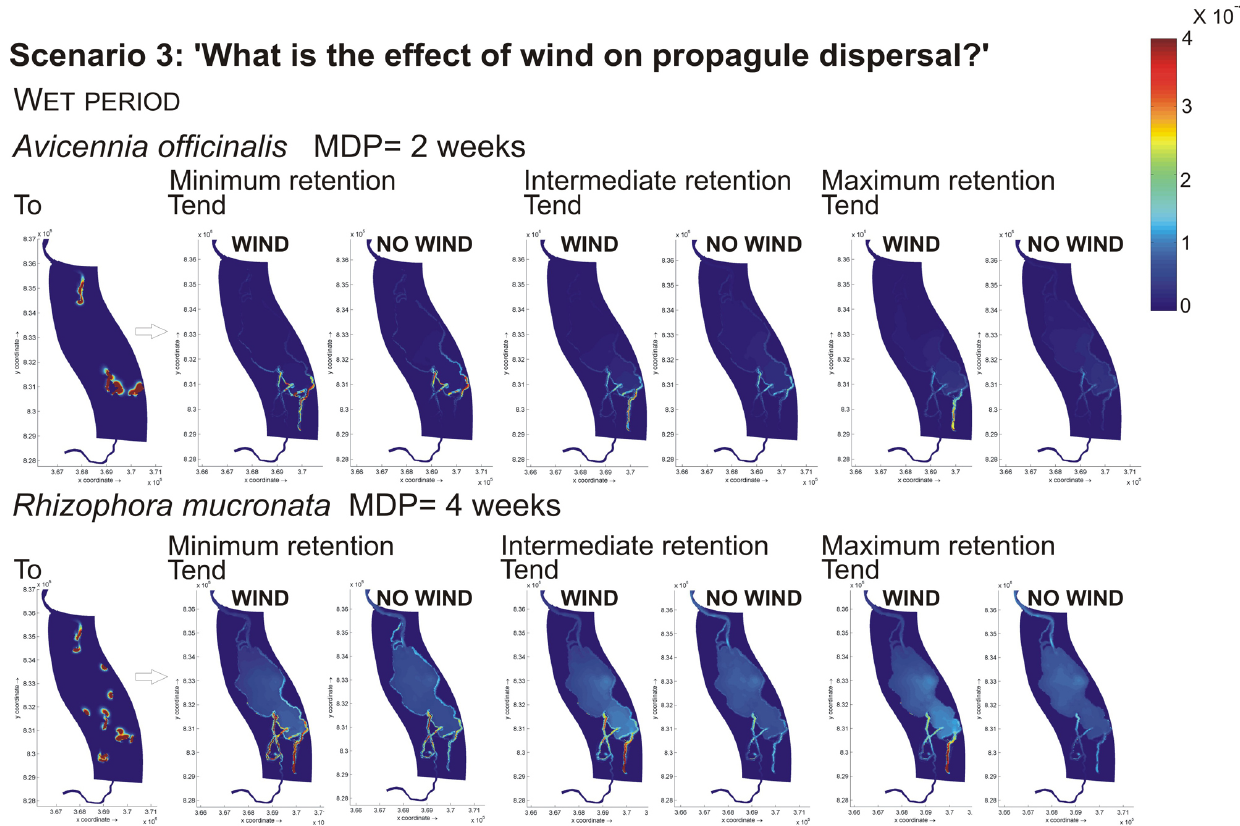
Fig. 7. Results of scenario 3 (the effect of “additional wind”) showing the distribution plots of propagules of Avicennia officinalis and Rhizophora mucronata . Scale is applicable to all distribution patterns. Red, yellow and light blue colours indicate a high, medium and low concentration of propagules